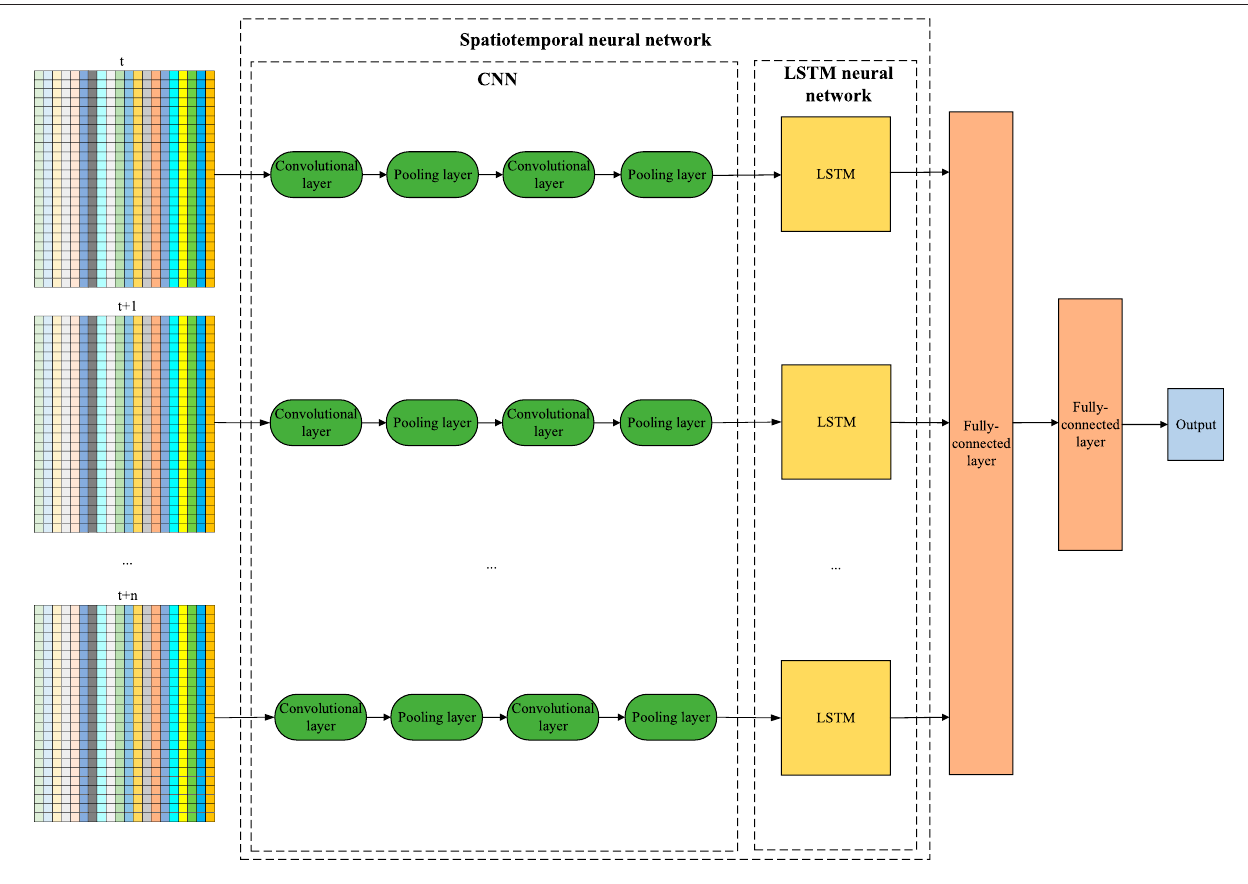
FIGURE 6 | CNN-LSTM model